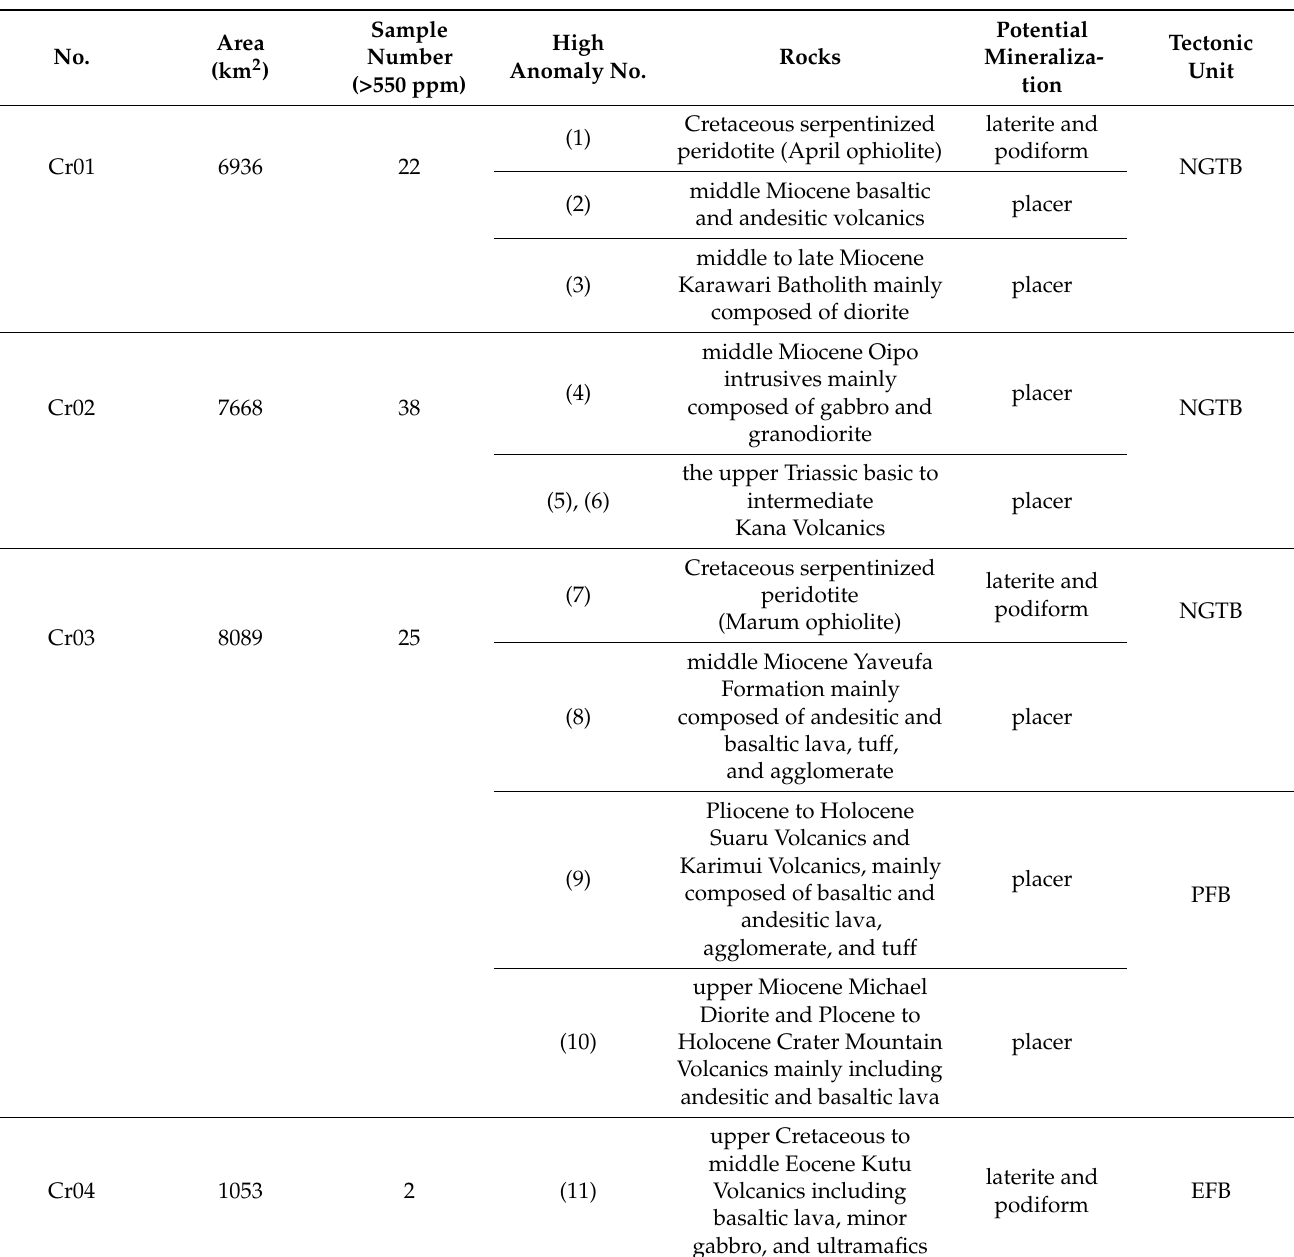
Table 5. Chromium geochemical anomalies of